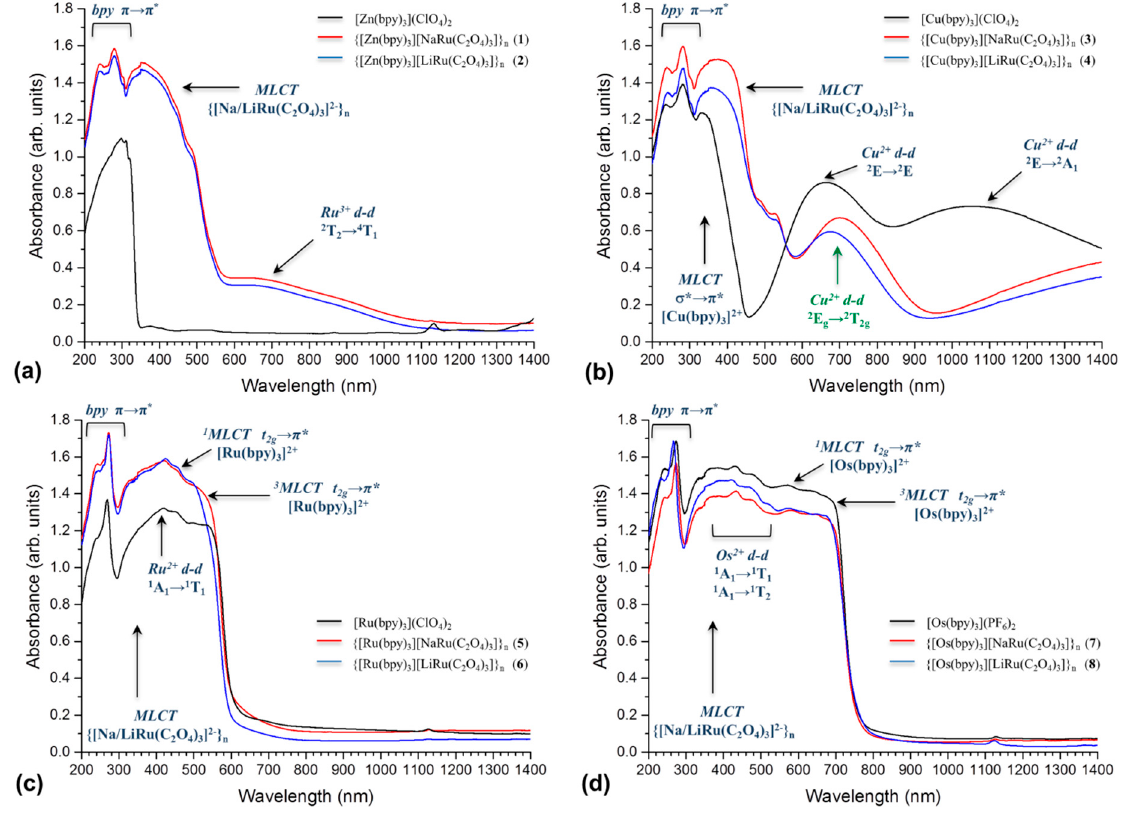
Figure 6. Comparison of room temperature UV–Vis–NIR diffuse-reflectance spectrum for: Figure